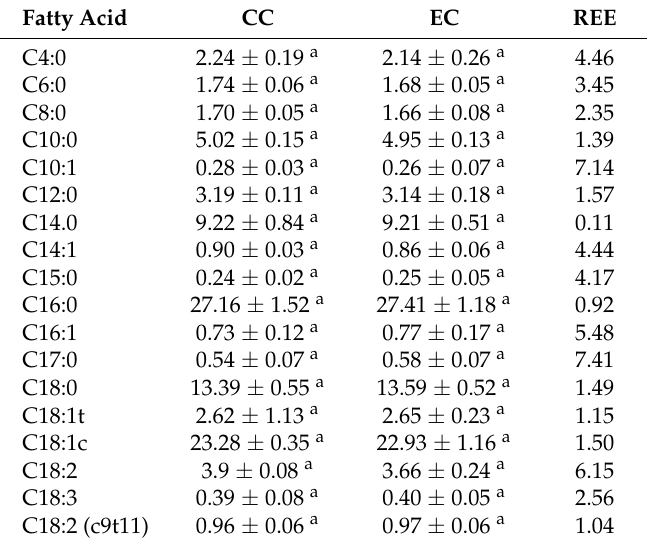
Table 2. Fatty acids composition (g/100 g fat) from the control and the experimental Manchego cheese by the effect of β